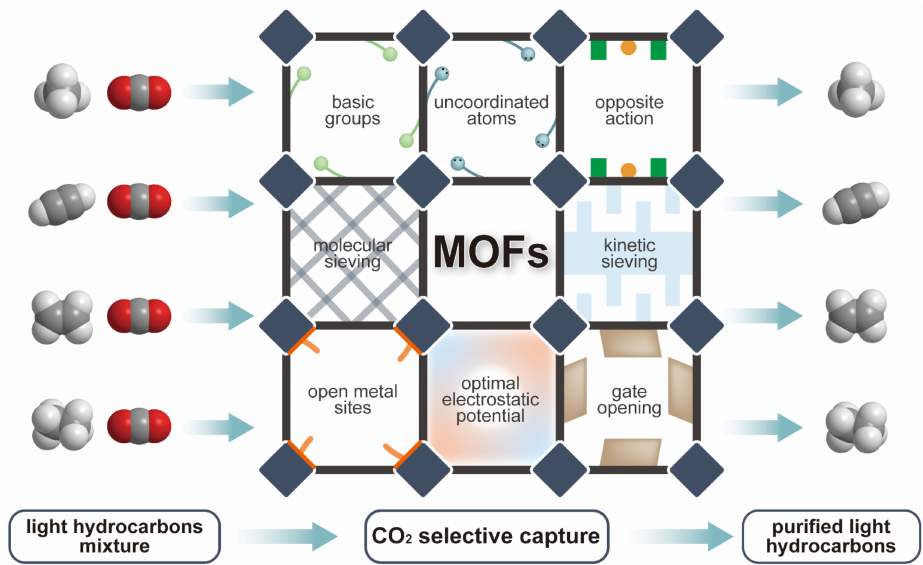
Figure 1. Schematic diagram of the process and typical strategies of CO 2 -selective capture from light hydrocarbon mixtures by metal-organic frameworks.